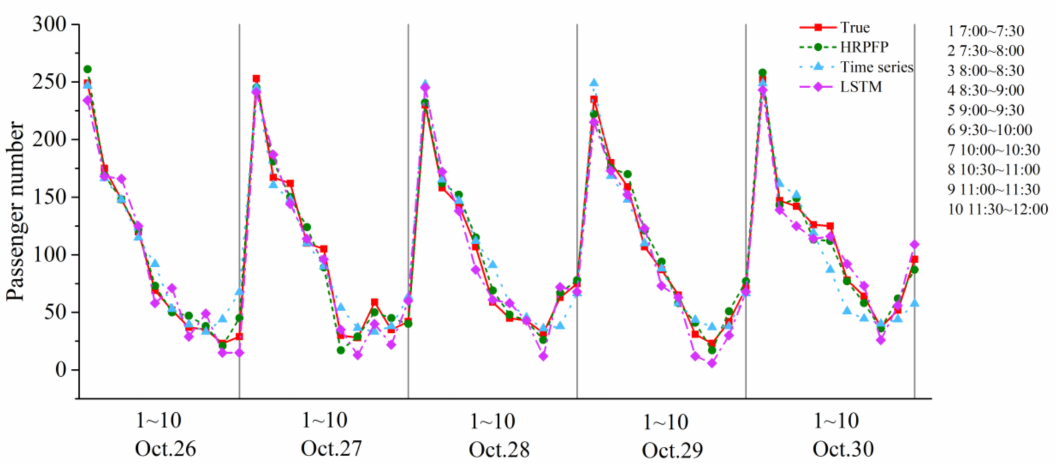
Figure 11. The comparison of three methods in passenger flow prediction using data from 7:00 to 12:00 for the 8 th station in line 56008.